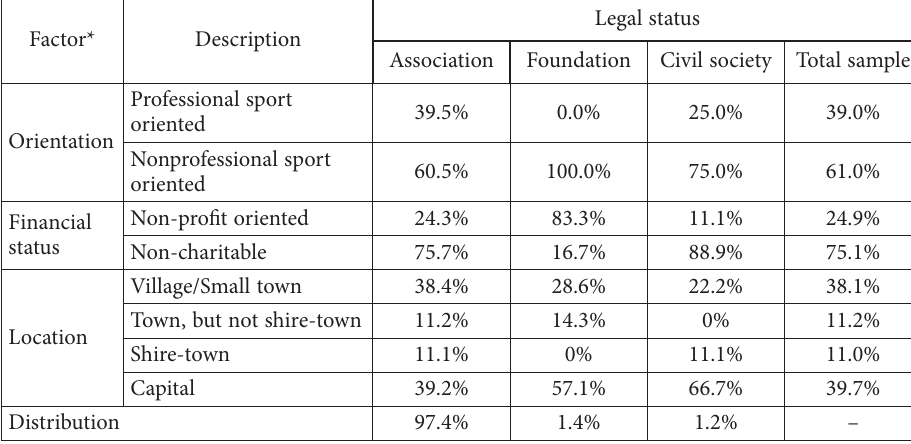
Table 1. Descriptions of the civil organizations by orientation, target, financial status and